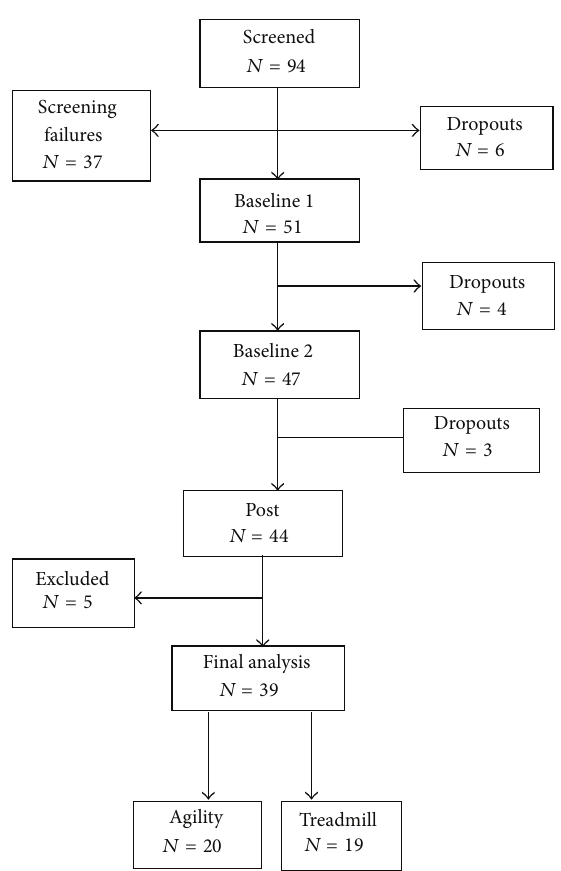
Figure 1: Consort diagram of recruitment and